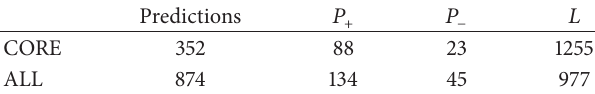
Table 3: 𝐿 value estimated by the GS sets.